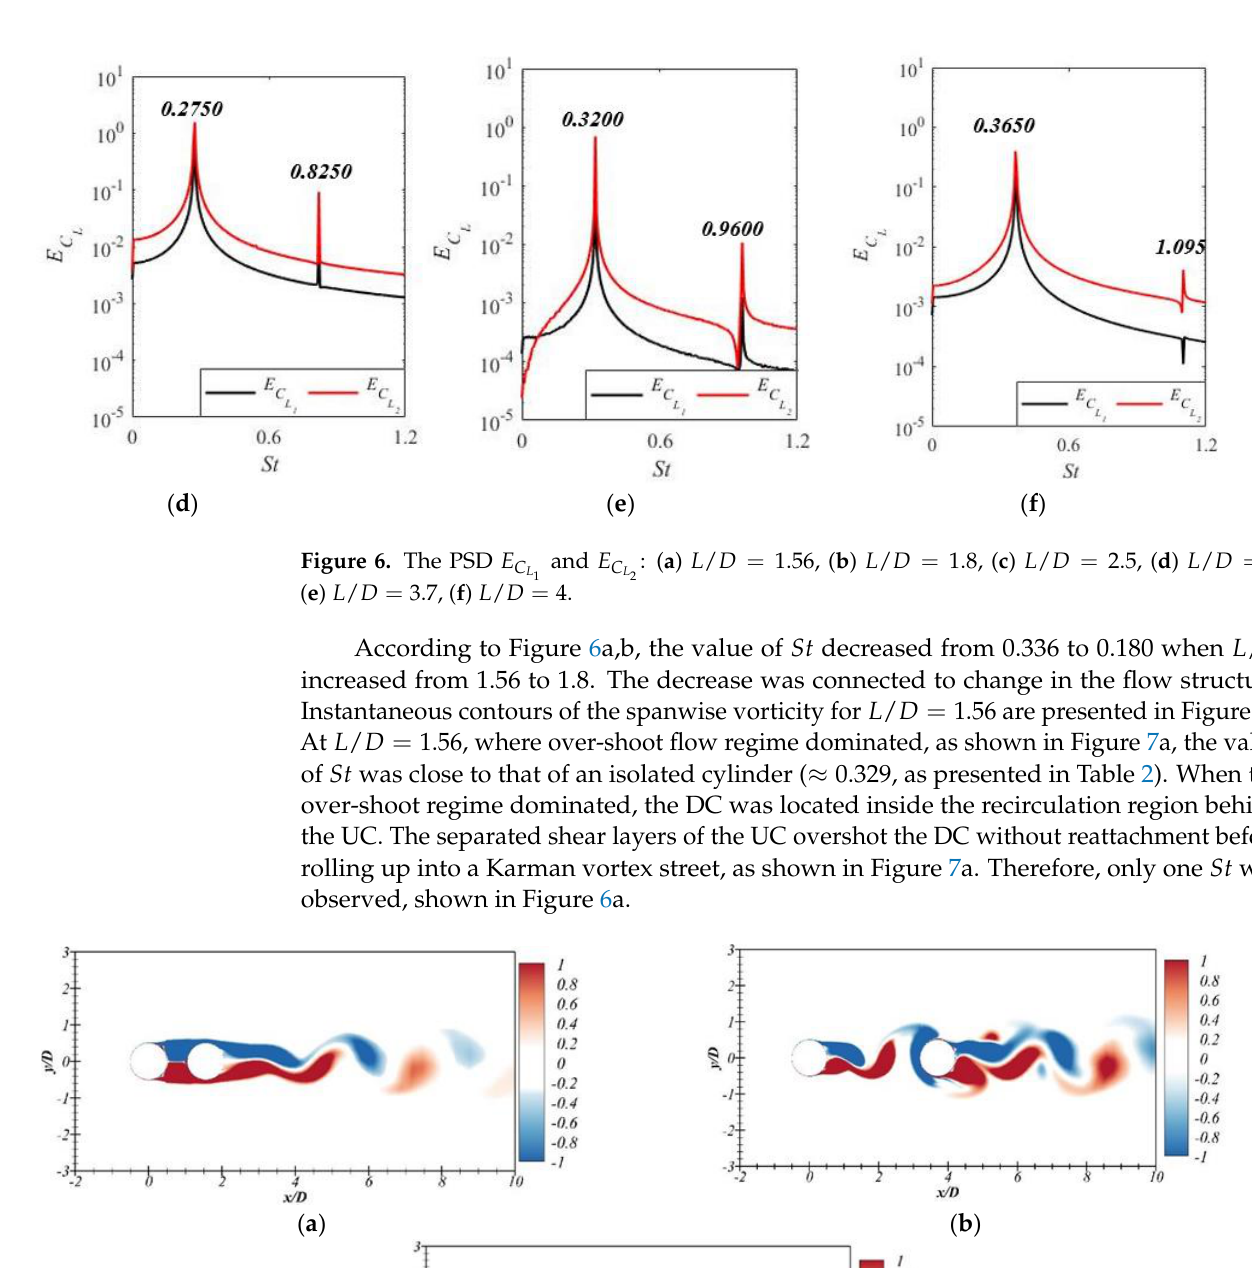
Figure 7. Instantaneous contours of the spanwise vorticity for ( a ) 𝐿/𝐷 = 1.56 ; ( b ) 𝐿/𝐷 = 3.7 ; ( c ) 𝐿/𝐷 = 4 .